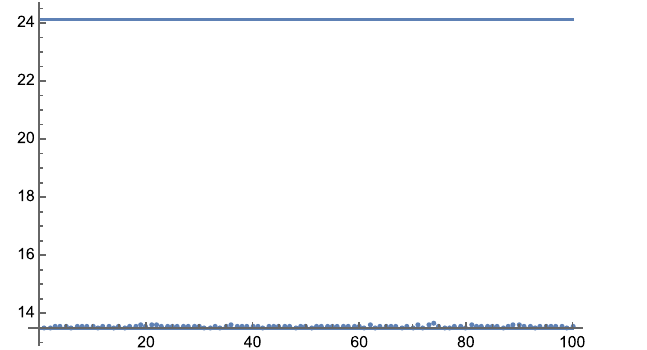
Fig. 4 The variances of Example 1 computed for 100 independent executions with the linear heuristic, taking 100 samples from each technique. The horizontal lines correspond to the optimal and equal sampling budget variances, respectively